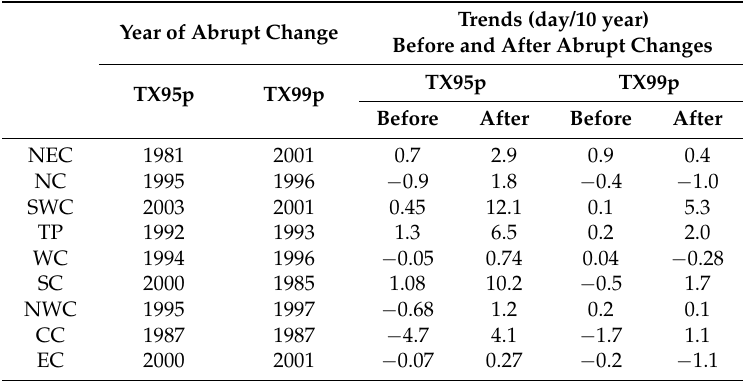
Table 3. Years of abrupt changes and trends before and after the abrupt changes in TX95p and TX99p among the climate zones. Trends (day/10 year) Year of Abrupt Change Before and After Abrupt Changes TX95p TX99p TX95p TX99p Before After Before After NEC 1981